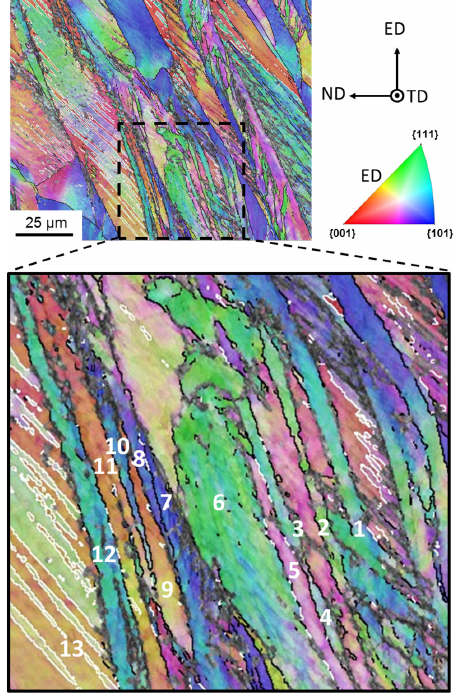
Figure 4. EBSD map with color ‐ coding according to the inverse pole figure after one ‐ pass ECAP. 13 grains were analyzed in the selected zone as illustrated in the inset. Black and white lines denote high ‐ angle grain boundaries ( θ ≥ 15°) and ∑ 3 (60°<111>) grain boundaries, respectively.